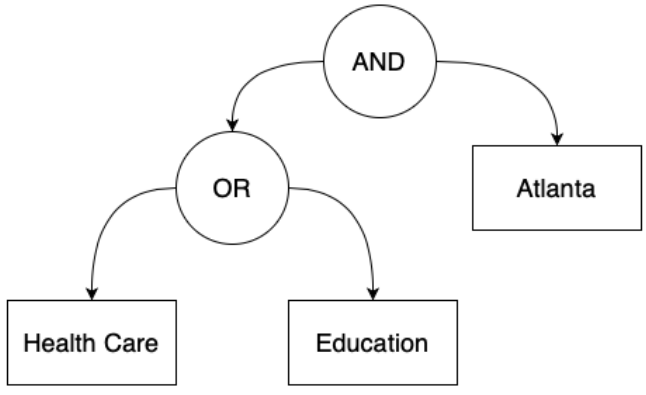
Figure 2. Example of an access